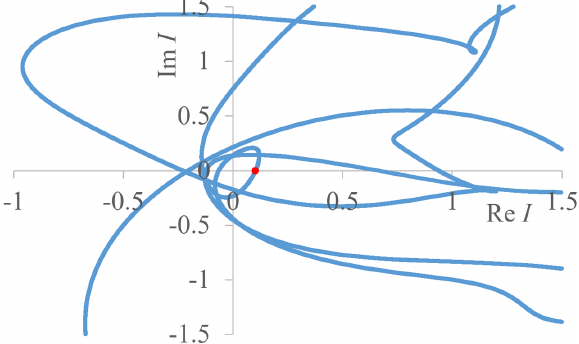
FIG. 7. Complex current plot for one of the mode configura- tions in MESA (only one pair of dipole modes is active). The threshold current value is marked with a red point.